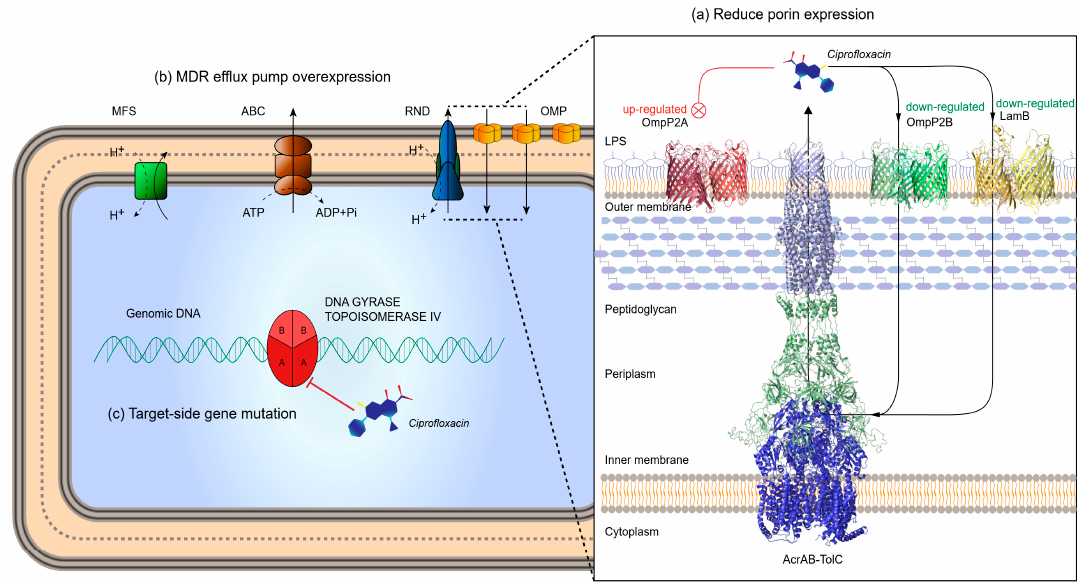
Figure 7. Mechanism of quinolone resistance of A. pleuropneumoniae . ( a ) Expression of major porins ompP2B and LamB was decreased, which reduced the drug concentration entering the periplasm. ( b ) Overexpression of multidrug resistance efflux pump reduced the intracellular drug concentraTable 1. RNA sequencing analysis. ( a ) Pearson correlation of all sample. ( b ) Heatmap showing gene expression patterns. ( c ) Volcano plots shows the difference of expression level between the wild and mutant